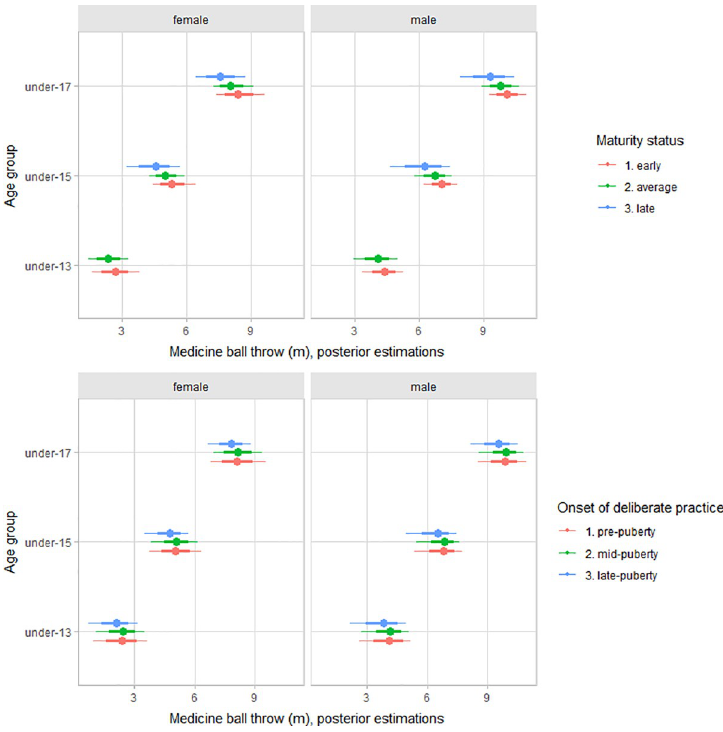
Fig 3. Posterior estimations and uncertainty (bold lines and thick ones represent 67% and 90% intervals, respectively) for 2-kg medicine ball throw performance by age group and contrasting age group by maturity status (upper plot), and the onset of deliberate practice (lower